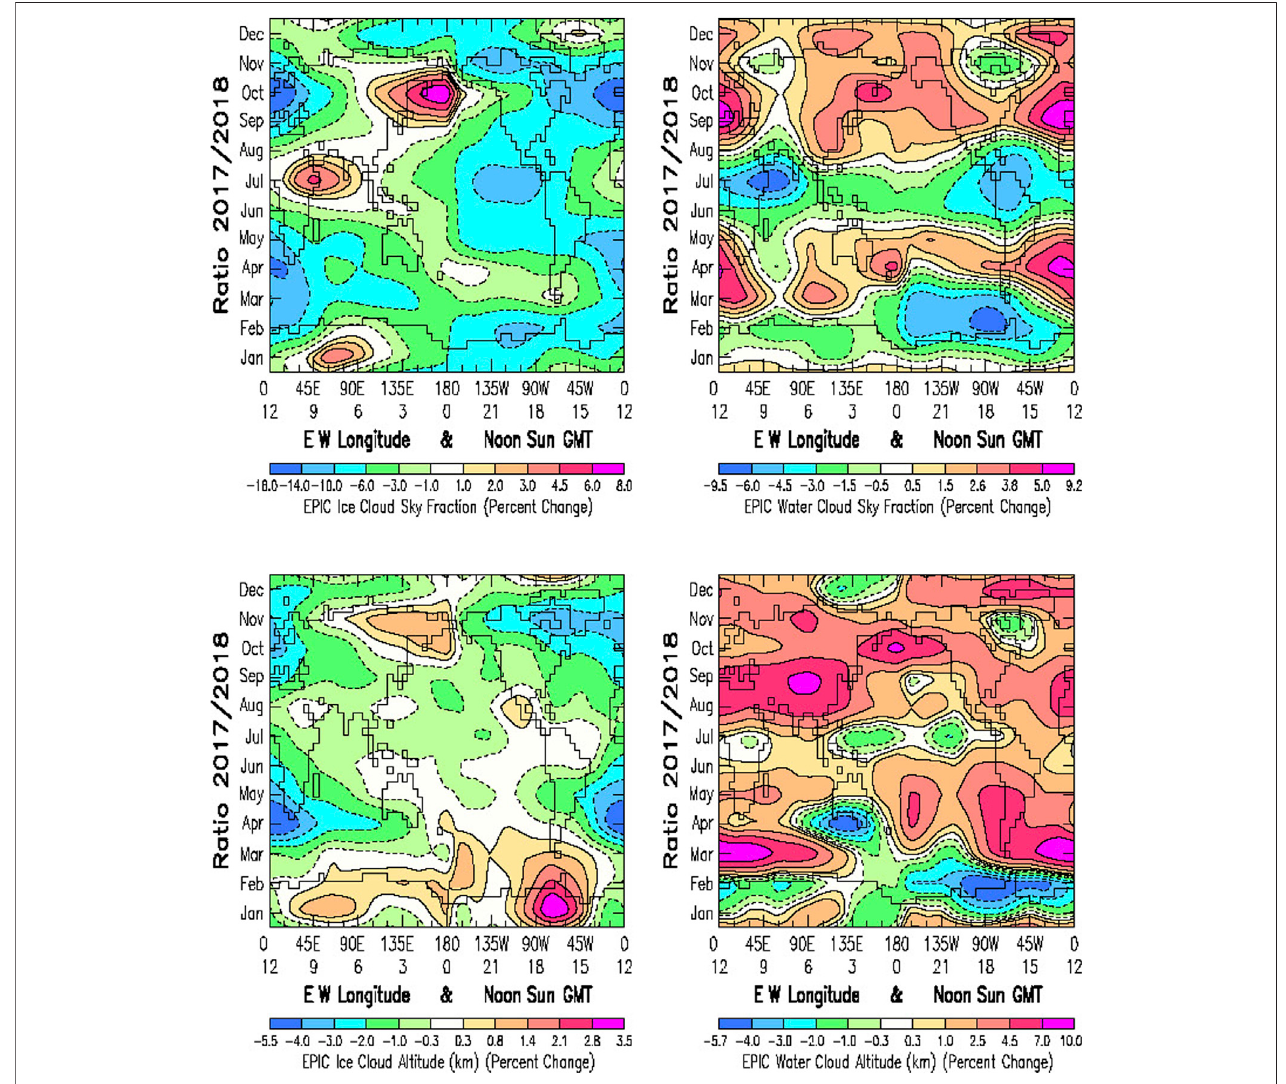
FIGURE 13 | Hovmöller ratio contour plots of the percent change for year 2017 relative to reference year 2018 of the EPIC Composite cloud property data for: Upper Left : the ice cloud sky fraction for years 2017/2018 from Figure 10 left; Upper Right : the water cloud sky fraction for 2017/2018 from Figure 10 right; Lower Left : the ice cloud altitude (km) for years 2017/2018 from Figure 12 left; Lower Right : the water cloud altitude (km) for 2017/2018 from Figure 12 right.